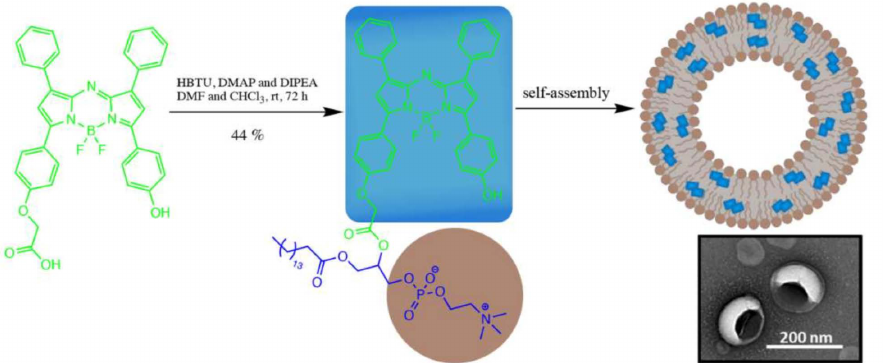
Figure 14. Self-assembly 67 into a BODIPYsome nanoparticle (phospholipid head group in brown and aza-BODIPY in blue). Adapted from